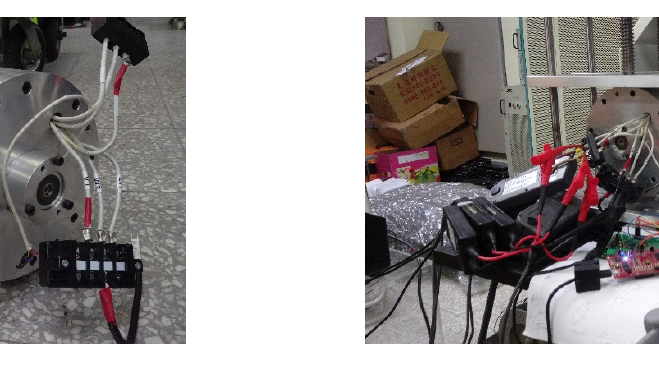
( c ) Figure 13. Measured current waveforms of developed FI-PMa-SynRM with the current of 32.5 A and angle of − 55 degrees: ( a ) Phase U; ( b ) Phase V; ( c ) Phase W.